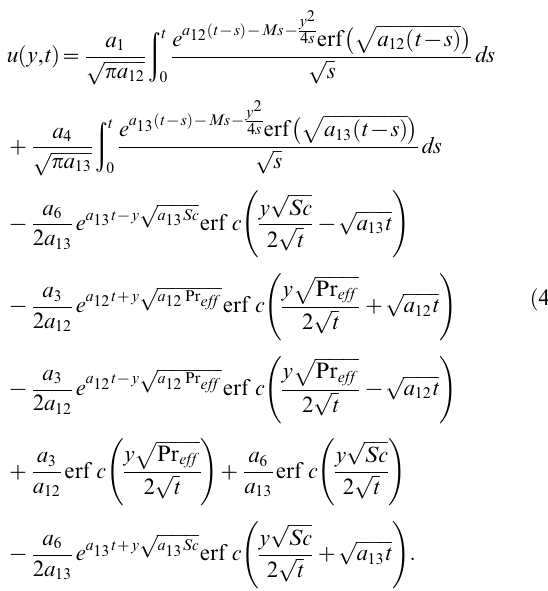
! y ffiffiffiffiffiffiffiffiffiffi Pr eff p p 2 ffiffi t ! p ! p p ffiffiffiffiffiffiffiffiffiffiffiffiffiffiffiffiffiffiffi a 12 t { 1 ð Þ p ffiffiffiffiffiffiffiffiffiffiffiffiffiffiffiffiffiffiffi a 12 t { 1 ð Þ